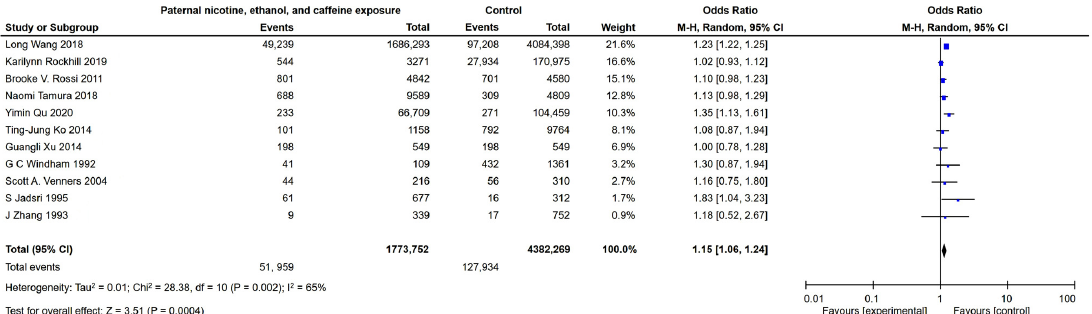
Figure 1. Meta analysis between paternal nicotine/ethanol/caffeine exposure and adverse preg- nancy outcomes. Retrieval type: ((Male) OR (paternal) OR (father)) AND (((alcohol intake) OR (alcohol consumption) OR (alcohol drinking)) OR ((Caffeine intake) OR (Caffeine consumption) OR (coffee drinking)) OR ((Nicotine intake) OR (Nicotine consumption) OR (tobacco smoking))) AND ((spontaneous abortion) OR (miscarriage) OR (stillbirth) OR (preterm birth) OR (low birth weight) OR (small for gestational age infants) OR (Intrauterine Growth Retardation) OR (Growth Retardation, Intrauterine) OR (Intrauterine Growth Restriction) OR (Fetal Growth Restriction)). Study or subgroup